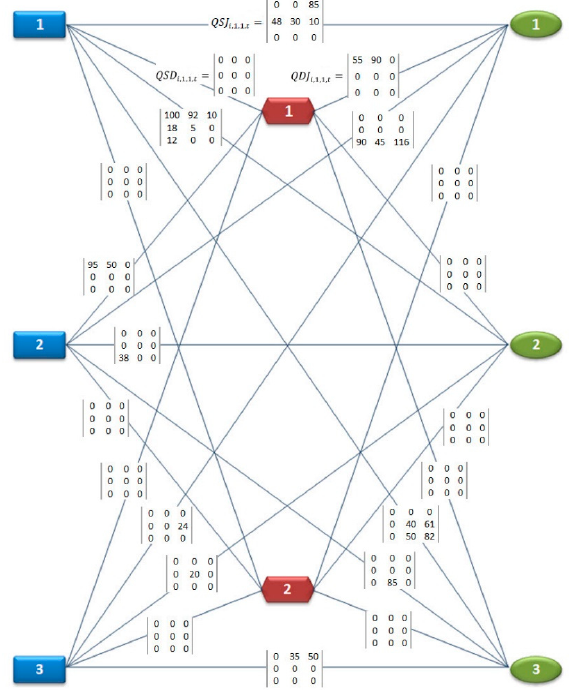
Figure 2. Quantities purchased and transported between the network nodes.